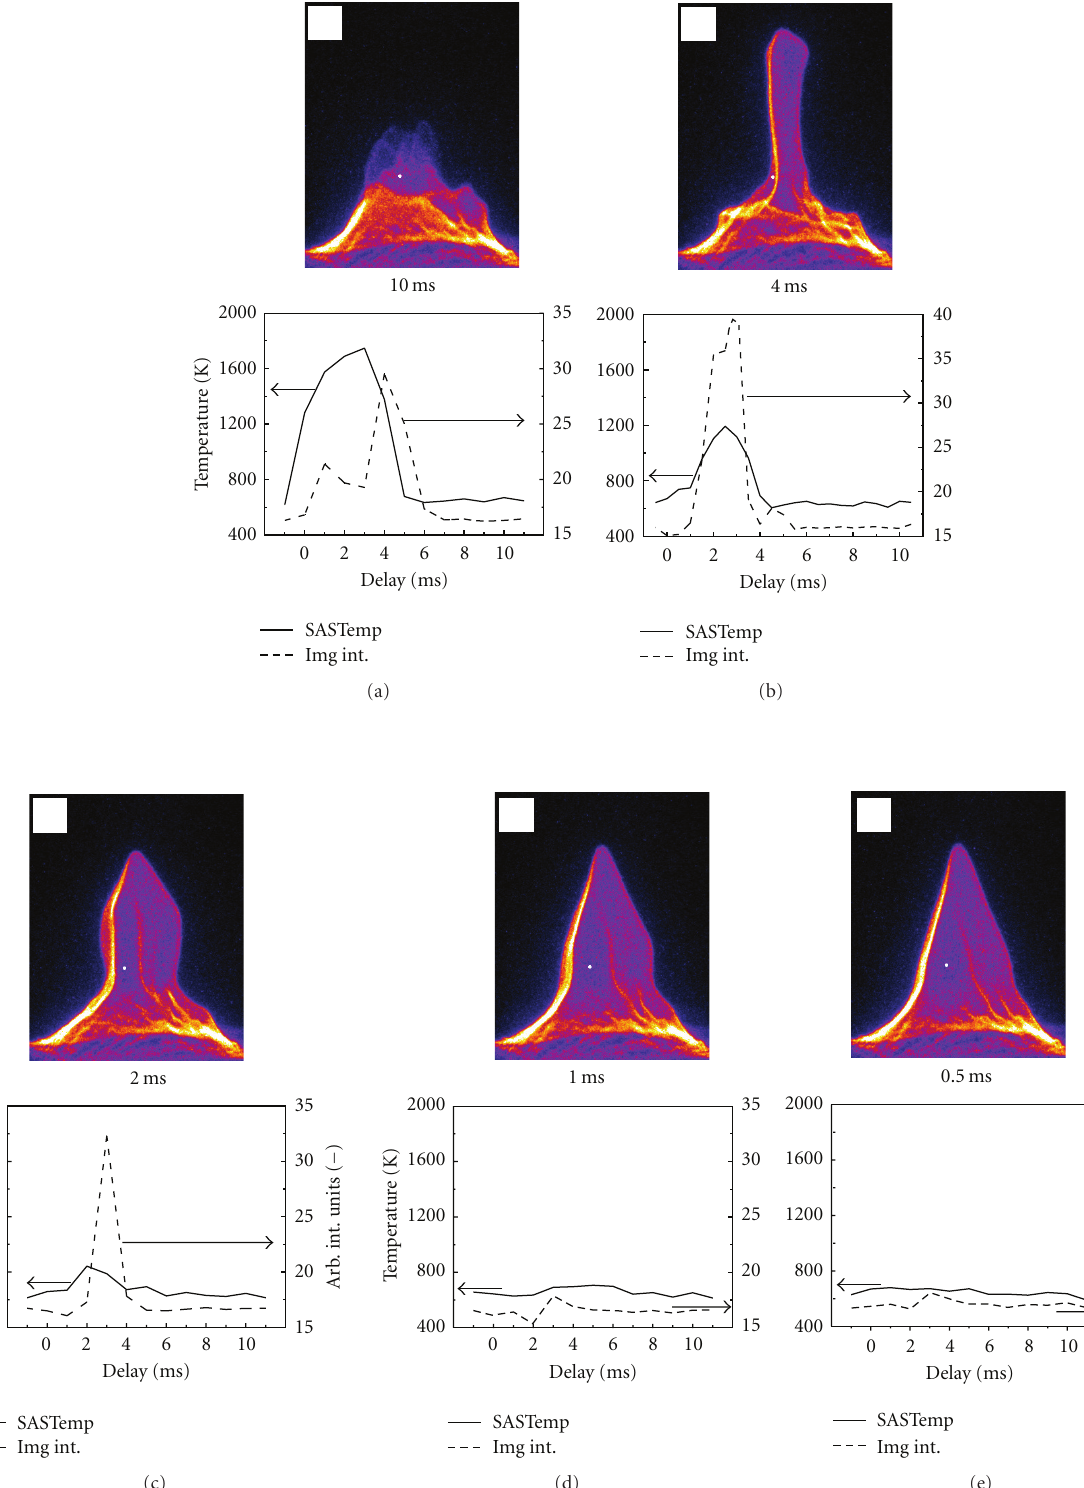
Figure 3: The e ff ect of +2.7kV variable voltage pulse width time, from 10ms to 0.5ms, on flame structure perturbation. Corresponding plots show strong positive correlation between combined Raman temperature and CH (A-X) chemiluminescence image signal intensity. The voltage pulse is applied to a Φ = 1.1 flame. All images were taken with the same time delay (2ms) from the end of the pulsed voltage. The white box in the upper-left corner of each image is 5mm by